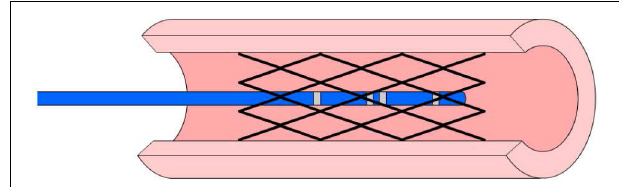
FIGURE 2 | A schematic of an impedance catheter in the lumen of a stented